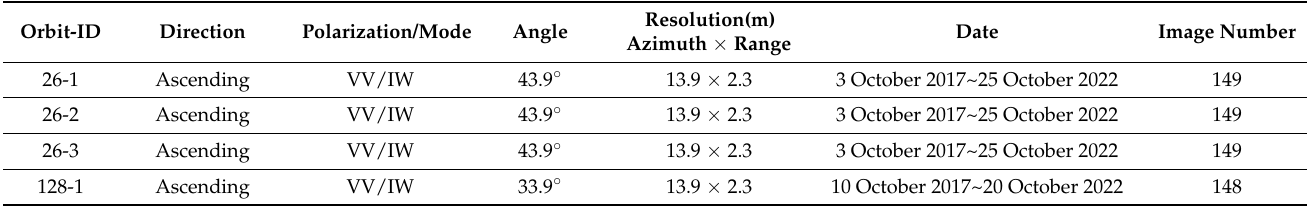
Figure 1. The study region. The blue line is the Dadu River. ( a ) is the topographic image. ( b ) is the Landsat false color image for 2021. ( c ) is the geological map of the Dadu River. The right figure is the location of the Dadu River in Sichuan. Table 1. Sentinel-1 SAR data used in the